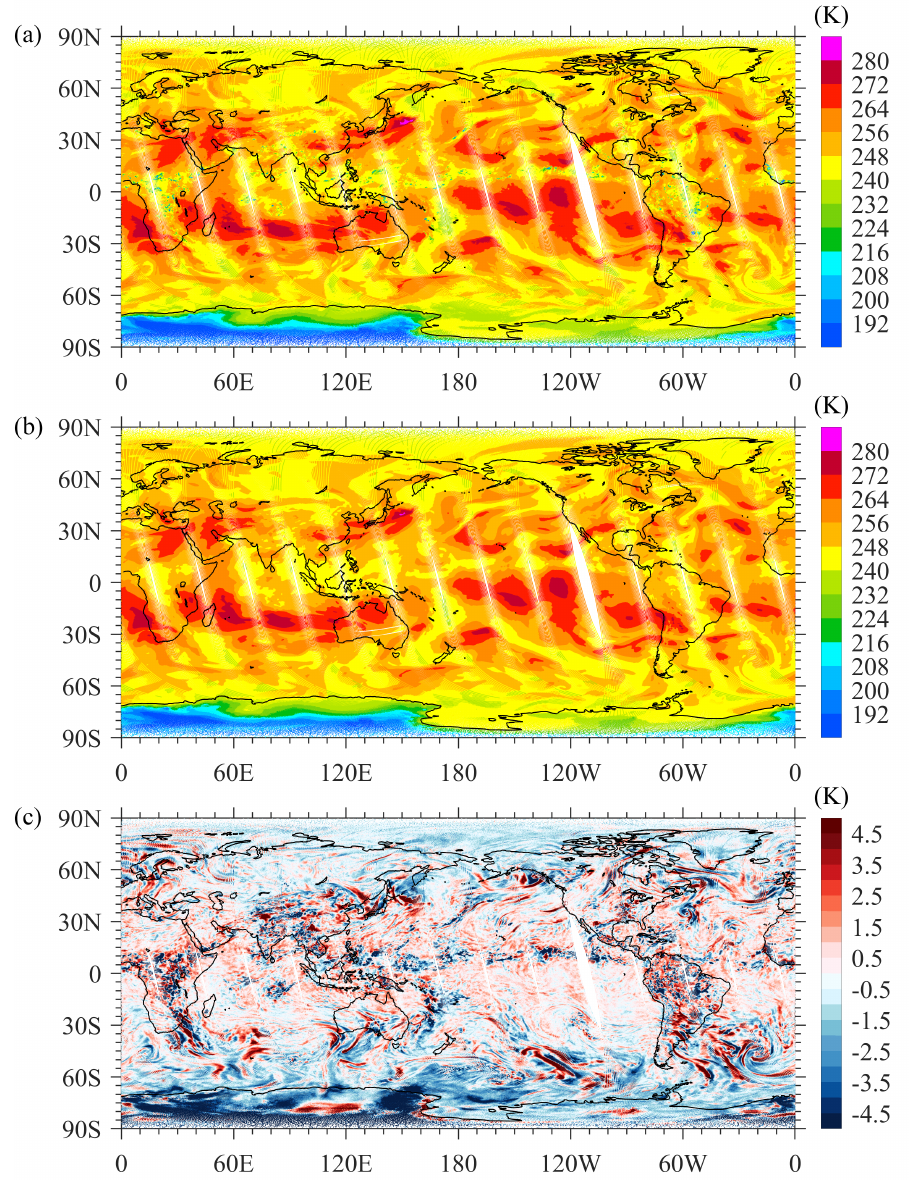
Figure 3. Spatial distribution of the: ( a ) observed; ( b ) simulated brightness temperature (unit: K); and ( c ) the difference (unit: K) between them (“O − B”) for Channel 12 (WF peaks at 500 hPa) on 2 October